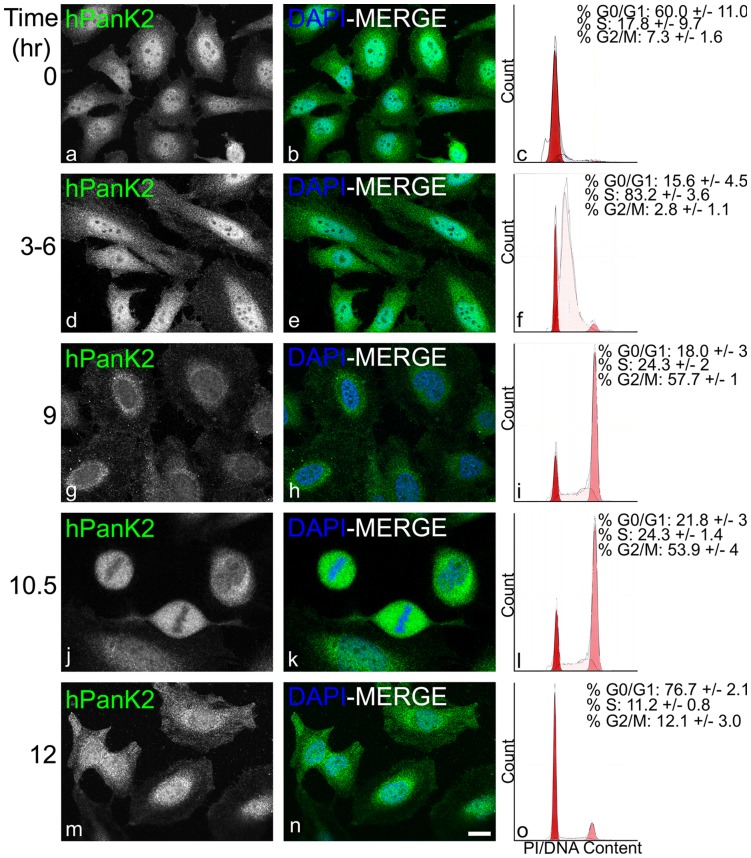
Dynamics of human PanK2 translocation during cell cycle progression.Synchronized Hela cells were released from a double thymidine block and immunostained with an anti-hPanK2 antibody to visualize hPanK2 (white, a, d, g, j and m; green, b, e, h, k, n) and heterochromatin (DAPI, blue; b, e, h, k and n) using fluorescent confocal microscopy. Representative images are shown at indicated times after release. Cell cycle distribution after release was determined in parallel experiments following propidium iodide staining of nuclear DNA and flow cytometry and representative data are shown (c, f, i, l, and o). The percentage of the cell population in each cell cycle phase was calculated using ModFit software at each time point (insets, c, f, I, l, o) and the average values ± s.e. from three independent experiments are indicated. Scale bar, 20 µm.